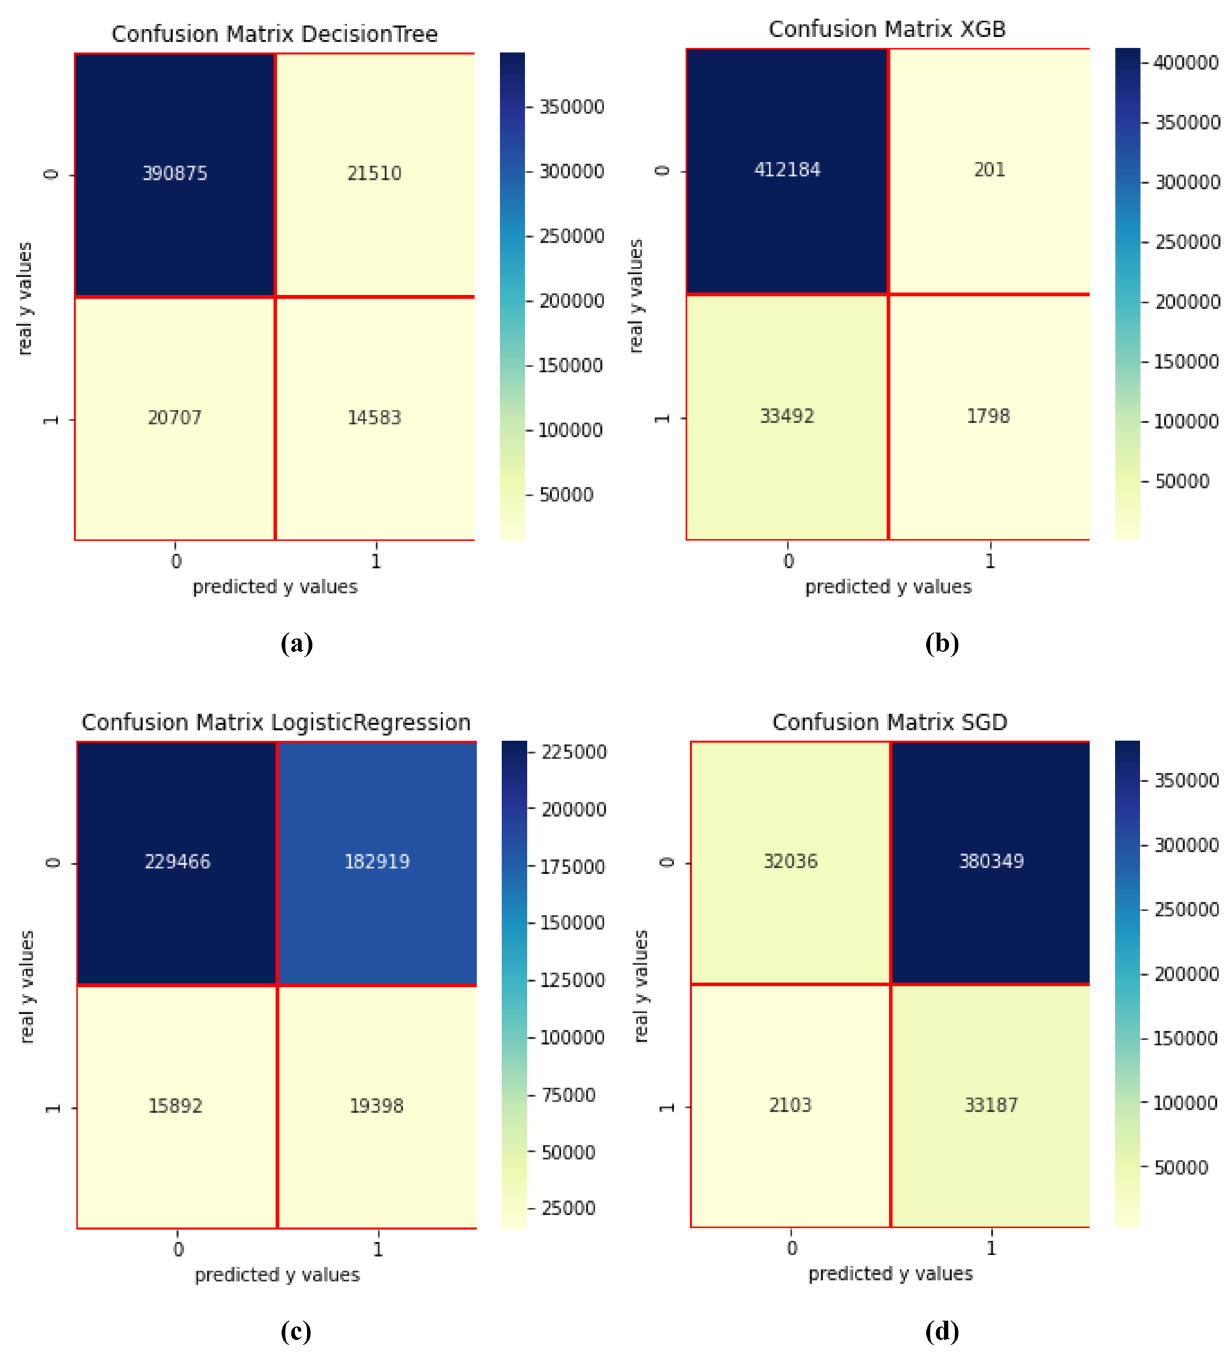
Figure 5. Confusion matrix—scenario 1. ( a ) DT, ( b ) XGB, ( c ) LR, ( d ) SGD.